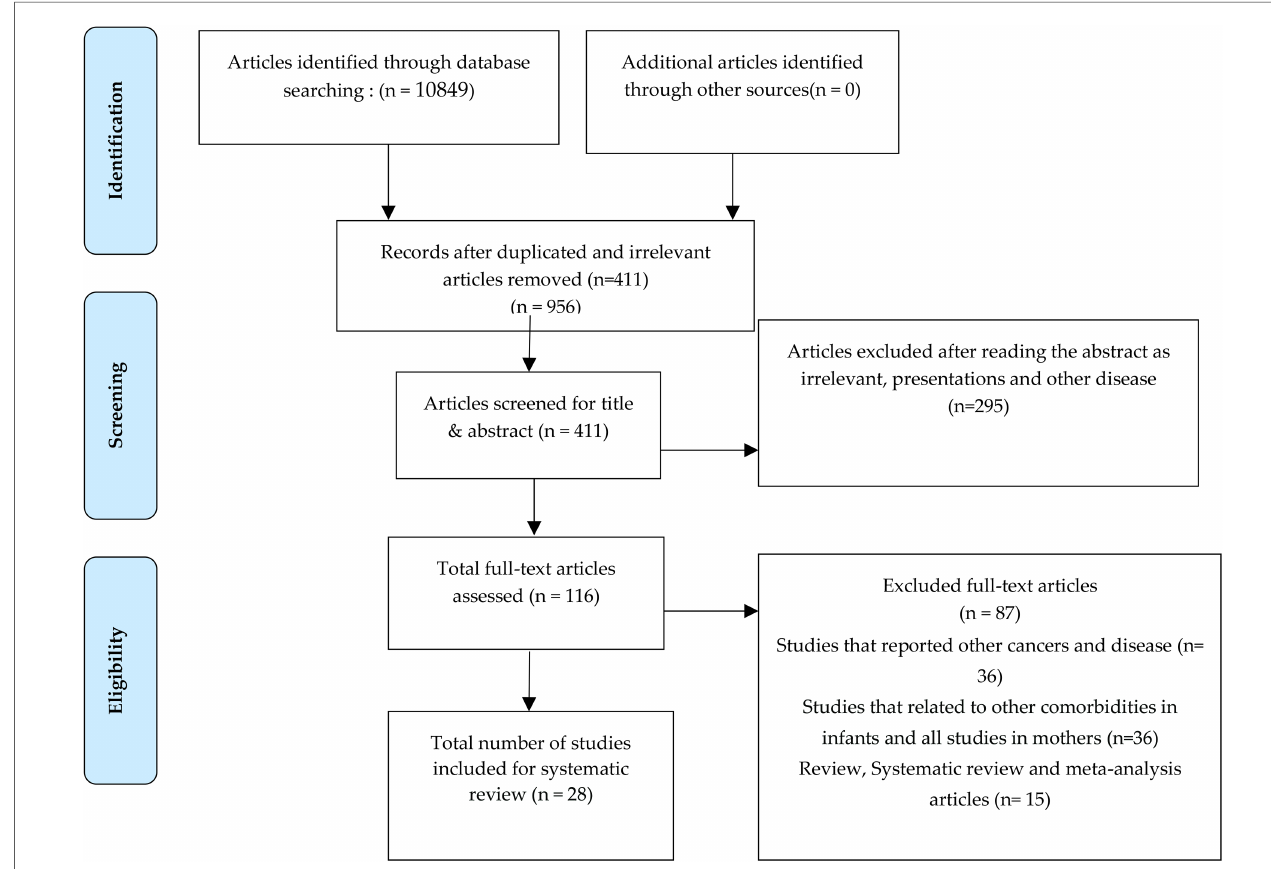
FIGURE 1 PRISMA fl ow